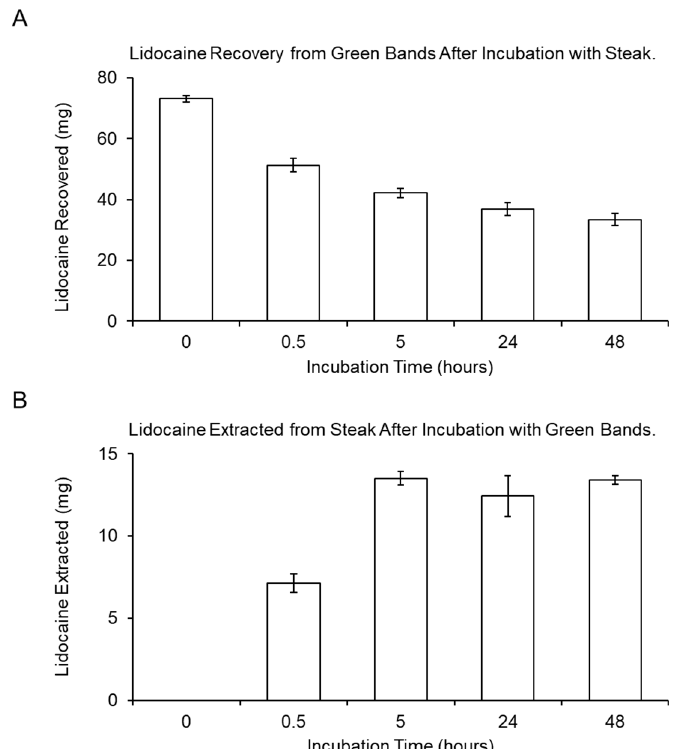
Figure 4. Lidocaine transfer kinetics between lidocaine-loaded, green castration bands and steak tissue. ( A ) The amount of lidocaine recovered from lidocaine-loaded green castration bands (LLBs) following various periods of incubation wrapped around steak tissue. ( B ) The amount of lidocaine extracted from steak tissue following various incubation periods wrapped with LLBs. Lidocaine was quantified by GC–MS. Bars represent the mean ± standard deviation for three independent replicates.